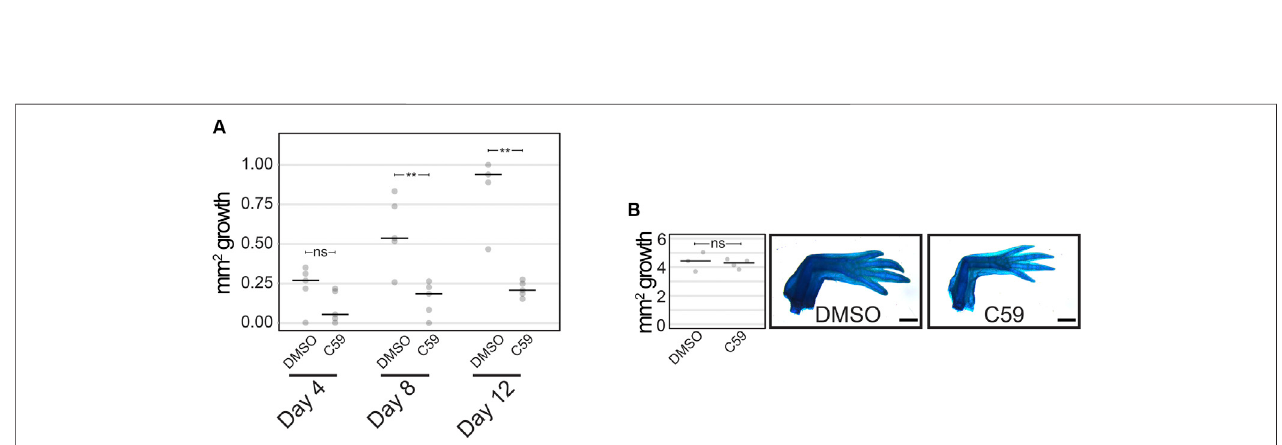
FIGURE 6 | Limb regeneration after Wnt inhibition. (A) Quanti fi cation of limb growth after C59 treatment starting at 3 dpa. Treated limbs were smaller than control limbsat8 dpa( p =0.0092;Student ’ st-test)and12 dpa( p =0.0031;Student ’ st-test). (B) Limbregenerationofuntreated(DMSO)andtreated(C59)limbs1monthafter removal from C59 (12